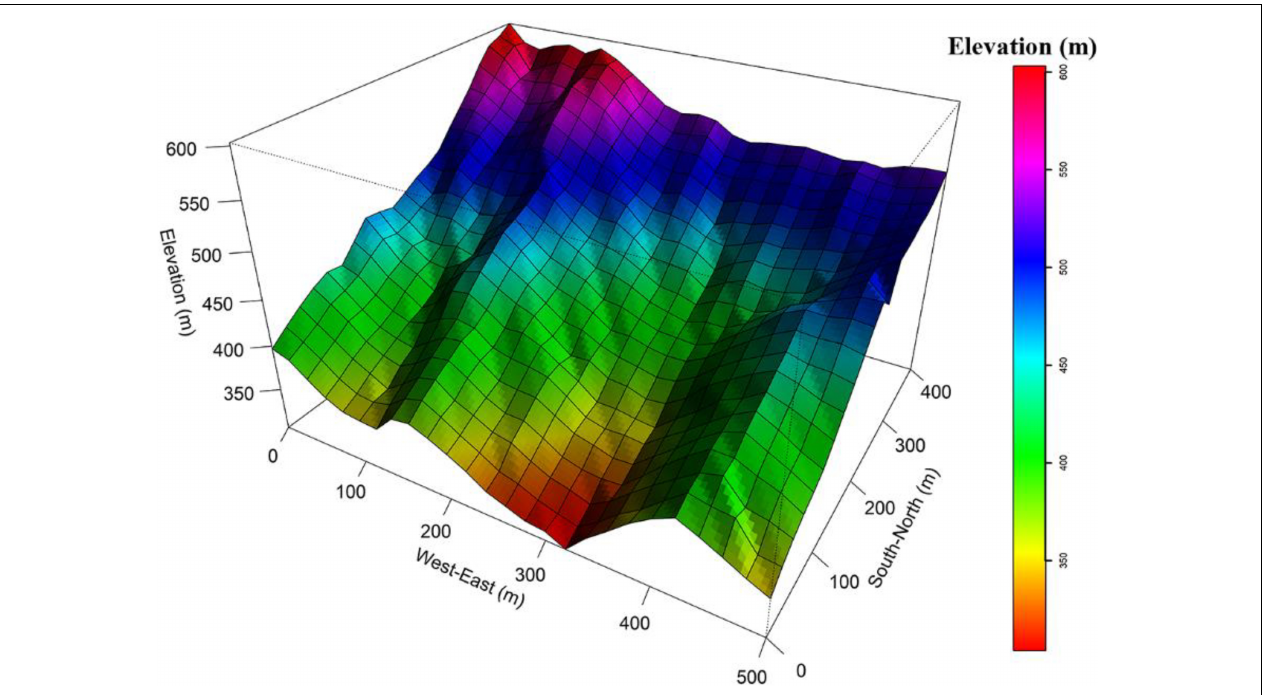
FIGURE 1 | The topography of the 20-ha Tiantong forest dynamics plot.